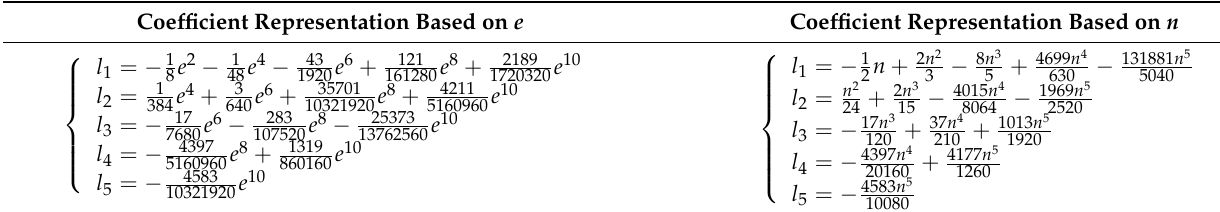
Table 7. Coefficients in Equation (15).